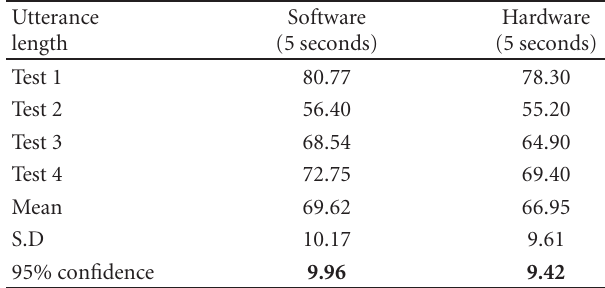
Table 1: Hardware and software results (percentage recognition accuracy) for testing with 5s test utterance.